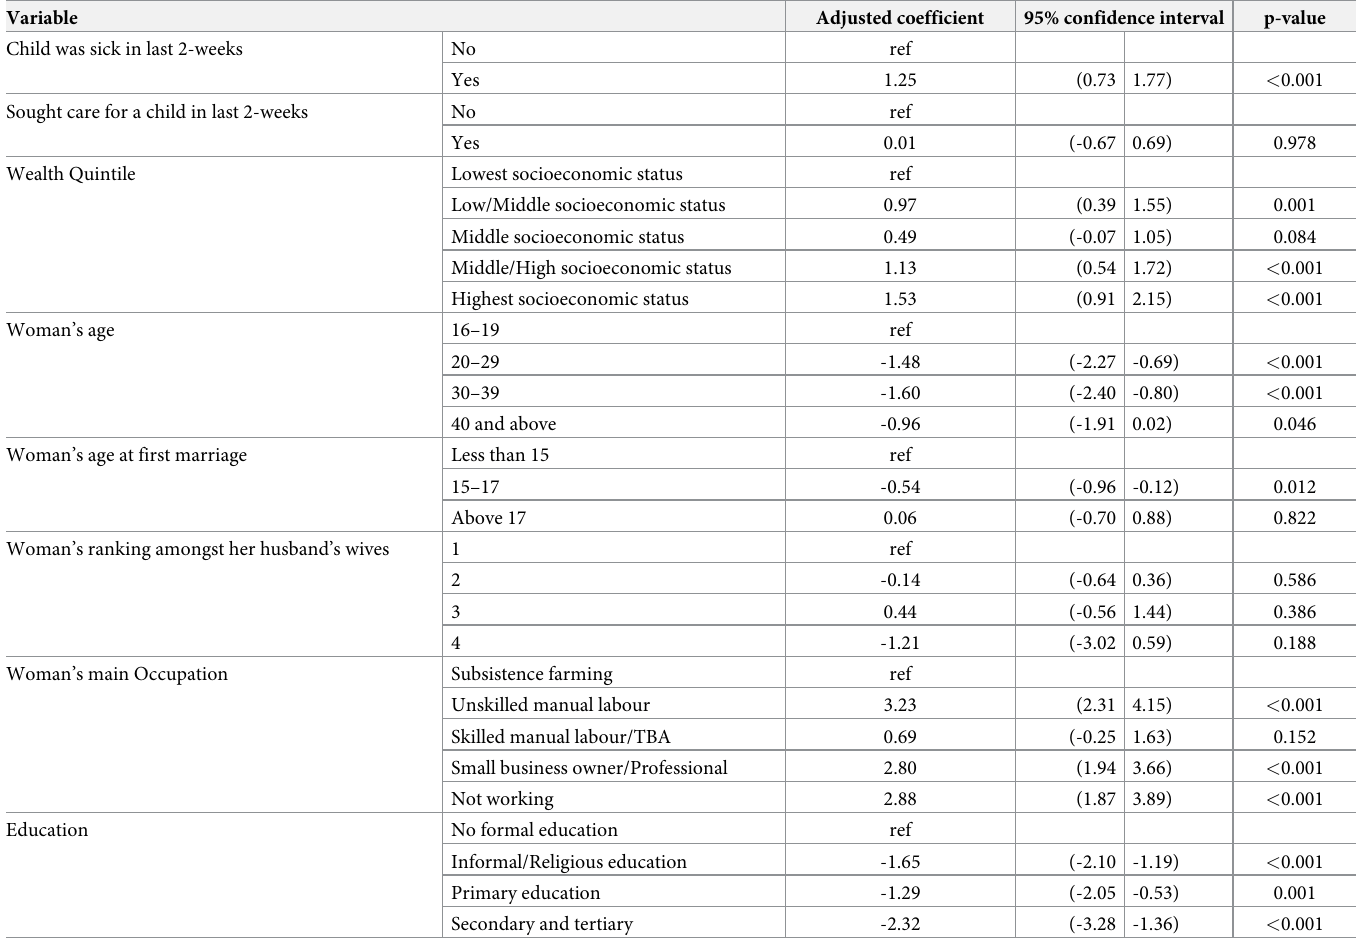
Table 3. Multivariable linear regression analysis of recent child illness and care-seeking and women’s well-being (adjusted R-squared =